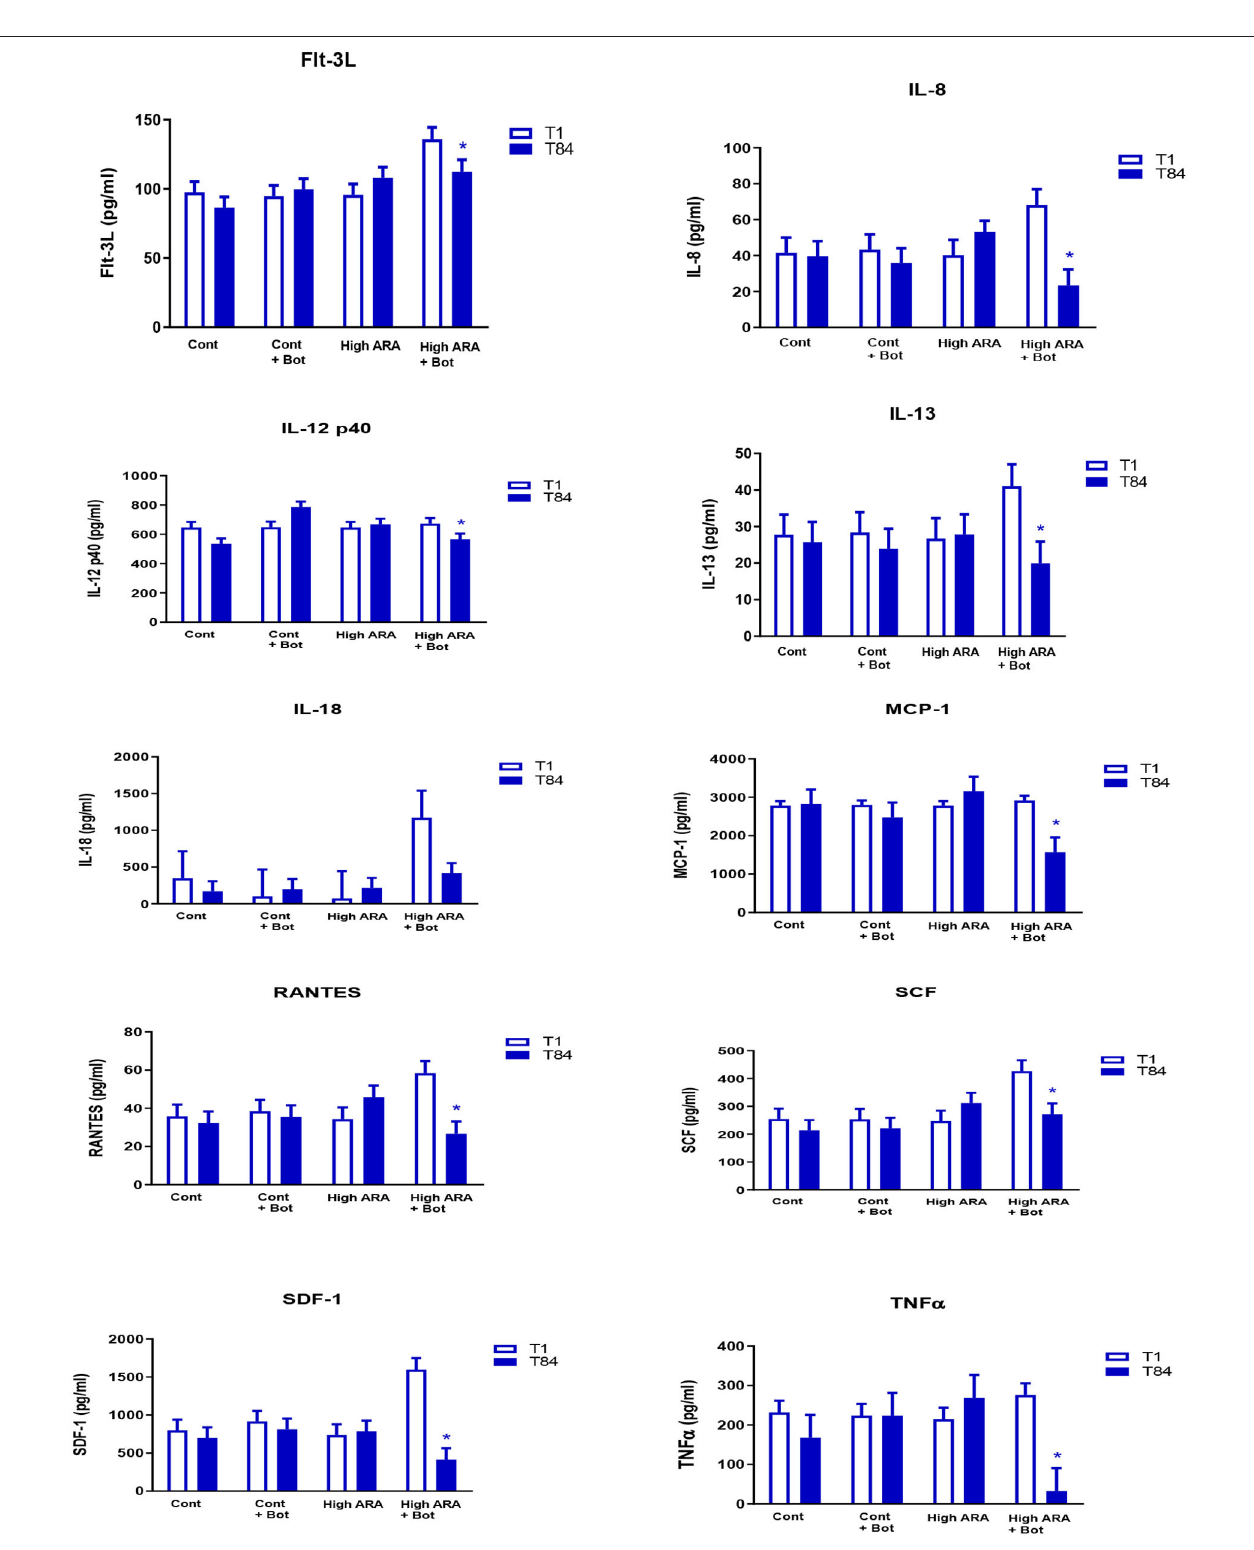
FIGURE 1 | Dietary influence e on circulating cytokine concentration (LSMeans with SE bars). e Treatments are as follows: Cont, a traditional adult cat food (control, 0.05% ARA no added botanicals); Cont + Bot, control food supplemented with with botanicals (green tea 0.5%, fenugreek 0.05%, and tulsi 0.003%); High ARA